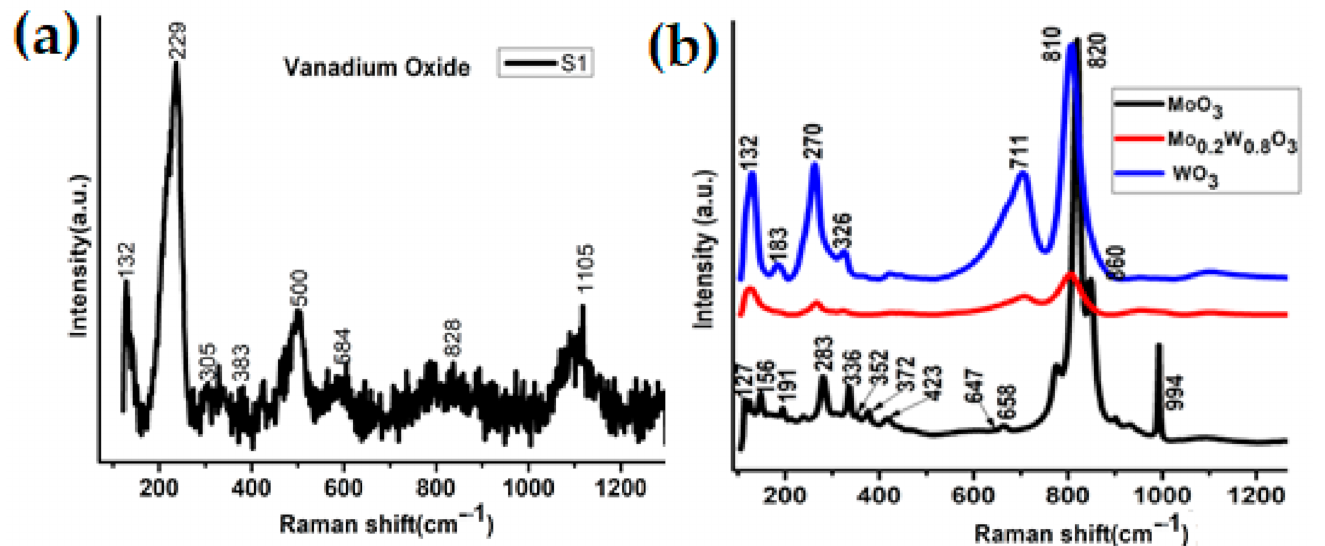
Figure 2. Raman spectra of the one-layer-based phase transition devices. ( a ) Characteristic Raman peaks of vanadium oxide (S1). ( b ) Characteristic Raman peaks of tungsten trioxide, molybdenum trioxide, and molybdenotungsten trioxide thin